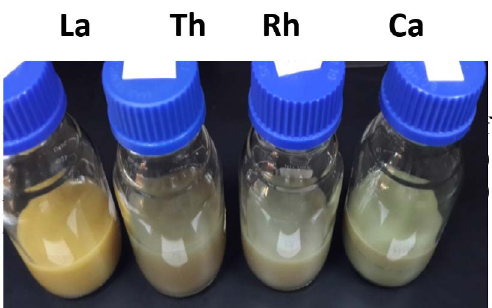
Fig. 2. The changes of color after added the leaf extracts to aqueous solution of silver nitrate (La) Lawsonia inermis , (Th) Thymus vulgaris , (Rh) Rhamnus frangula and (Ca) Camellia sinensis